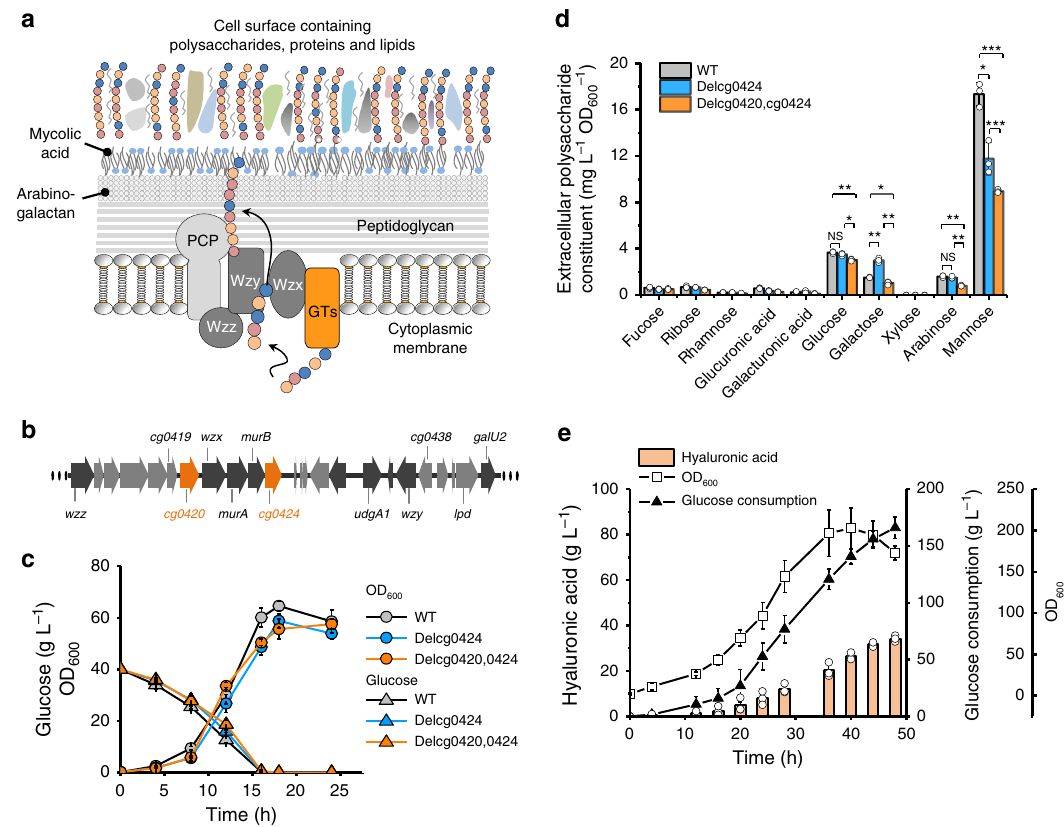
Fig. 2 Deletion of cg0420 and cg0424 to improve HA production. a The model of the C. glutamicum cell envelope structure 38,39 . Extracellular polysaccharides/cell-surface polysaccharides, proteins and lipids are attached to the mycolic acid and arabinogalactan layer to form the outmost layer of the C. glutamicum cell wall. The Wzx/Wzy-dependent pathway predicted to participate in synthesis of cell-surface polysaccharides 41 . GTs, glycosyltransferases; PCP, polysaccharide co-polymerase. b Gene cluster putatively involved in synthesis of cell-surface polysaccharides. Genes cg0419 , cg0420 , cg0424 , and cg0438 found in close proximity to wzx and wzy were predicted to code glycosyltransferases. c Growth and metabolism of C. glutamicum ATCC 13032 (WT), cg0424 deletion strain (Delcg0424) or cg0420 and cg0424 double deletion strain (Delcg0420,0424). d Sugar constituent of cell-surface polysaccharides isolated from C. glutamicum ATCC 13032 (WT), cg0424 deletion strain (Delcg0424) and cg0420 and cg0424 double